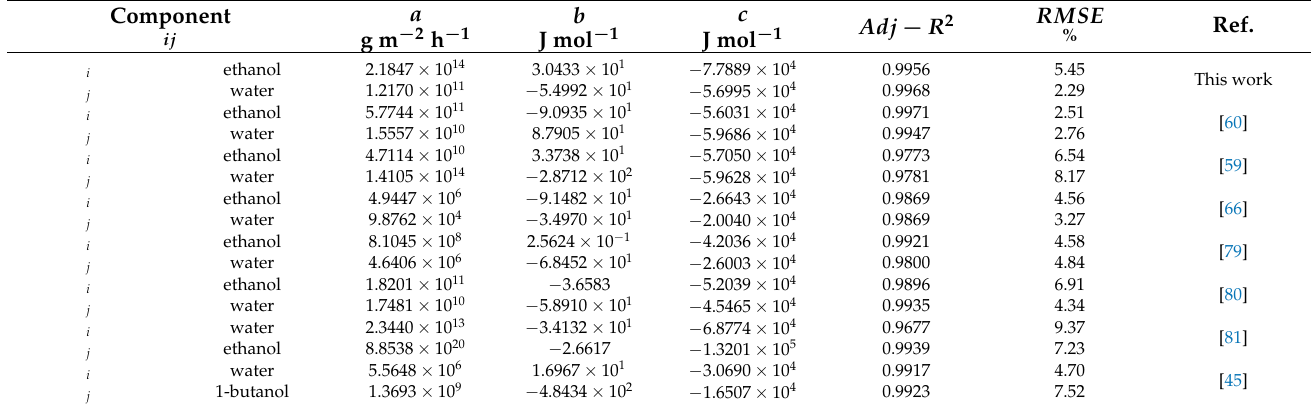
Table 5. Partial flux model application on experimental pervaporation